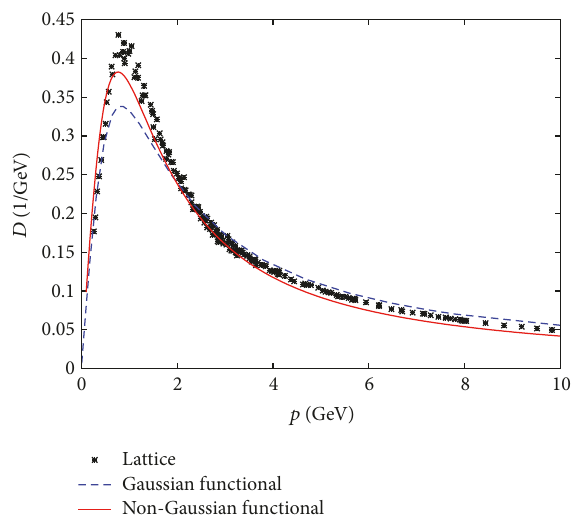
Figure 5: The static gluon propagator in Coulomb gauge calculated on the lattice for SU (2) gauge theory (crosses). The dashed and the full curves show the result of the variational calculation using, respectively, a Gaussian and non-Gaussian ansatz for the vacuum wave